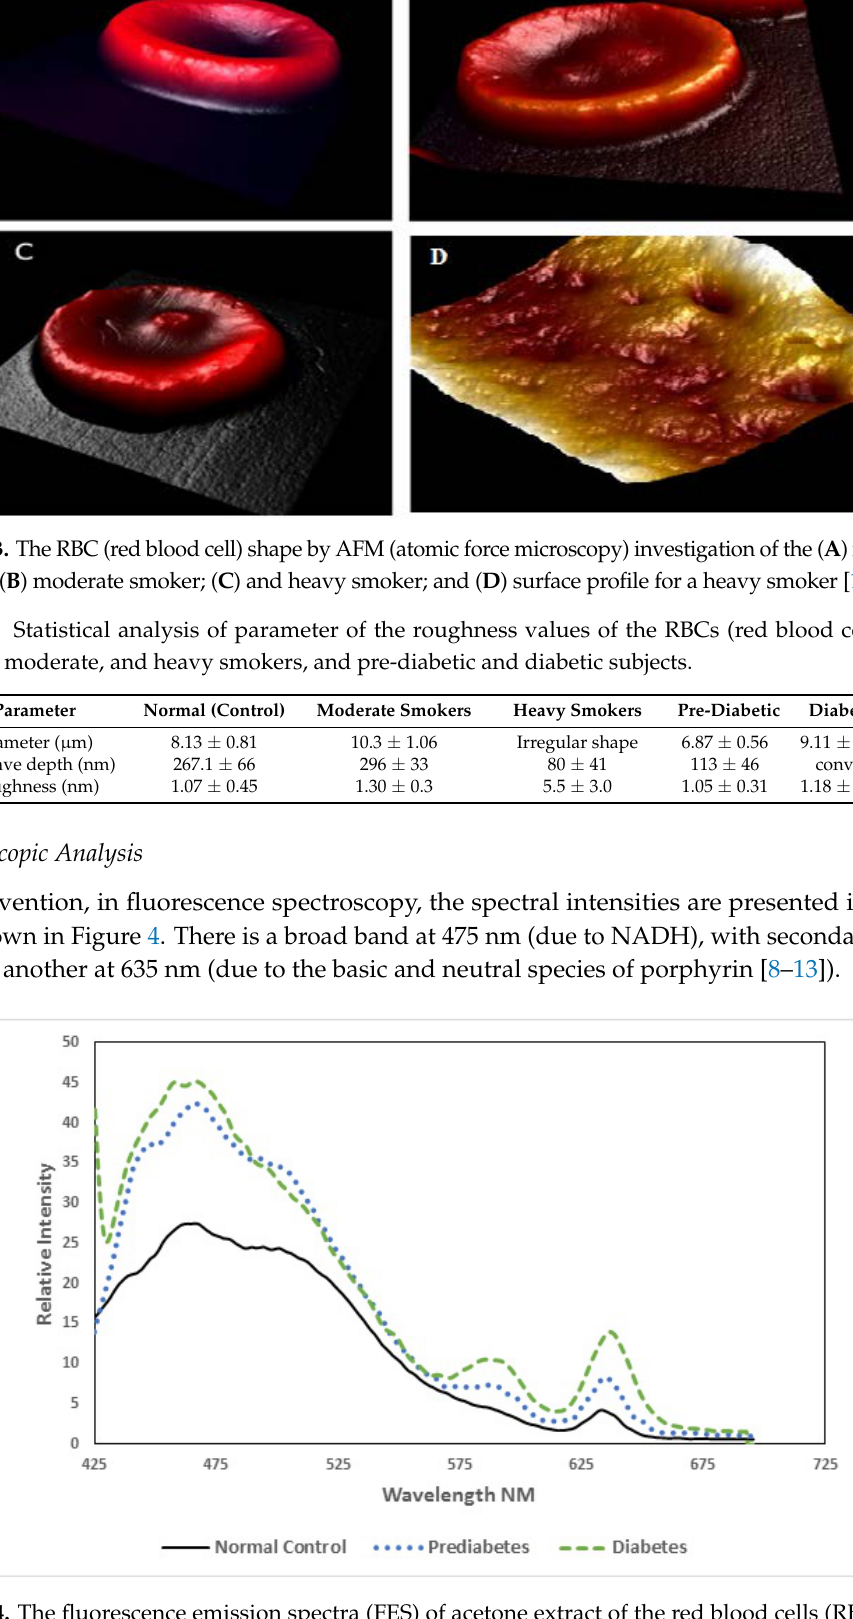
Figure 4. The fluorescence emission spectra (FES) of acetone extract of the red blood cells (RBCs) of (a) normal control, (b) pre-diabetic subjects, and (c) diabetic patients.